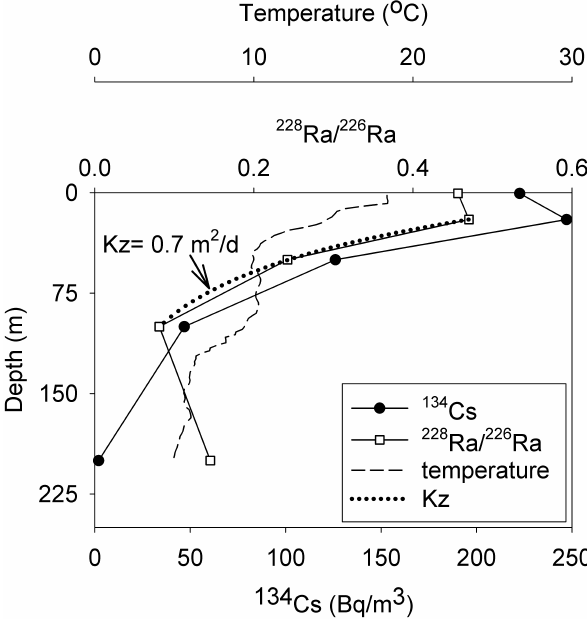
Fig. 6. The upper ocean distribution of 228 Ra / 226 Ra and 134 Cs at station 21. The vertical gradient in 228 Ra / 226 Ra was used to derive the eddy diffusivity ( K z ) and ultimately the transport of Cs across the thermocline within the study domain.